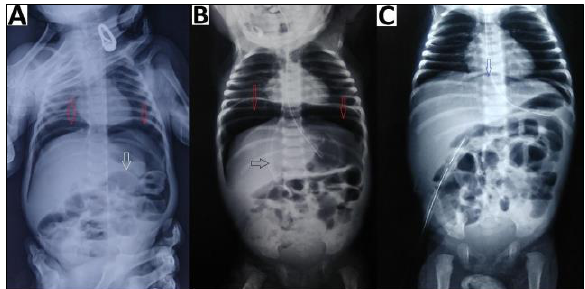
Figure 2: Abdominal radiographs (erect) (A) showing gas under the diaphragm (red arrows), Rigler sign (white arrow); supine image (B) showing pneumoperitoneum (red arrows), outlining of falciparum ligament (black arrow); erect image (C) showing resolution of pneumoperitoneum (blue arrow) with abdominal drain in-situ.